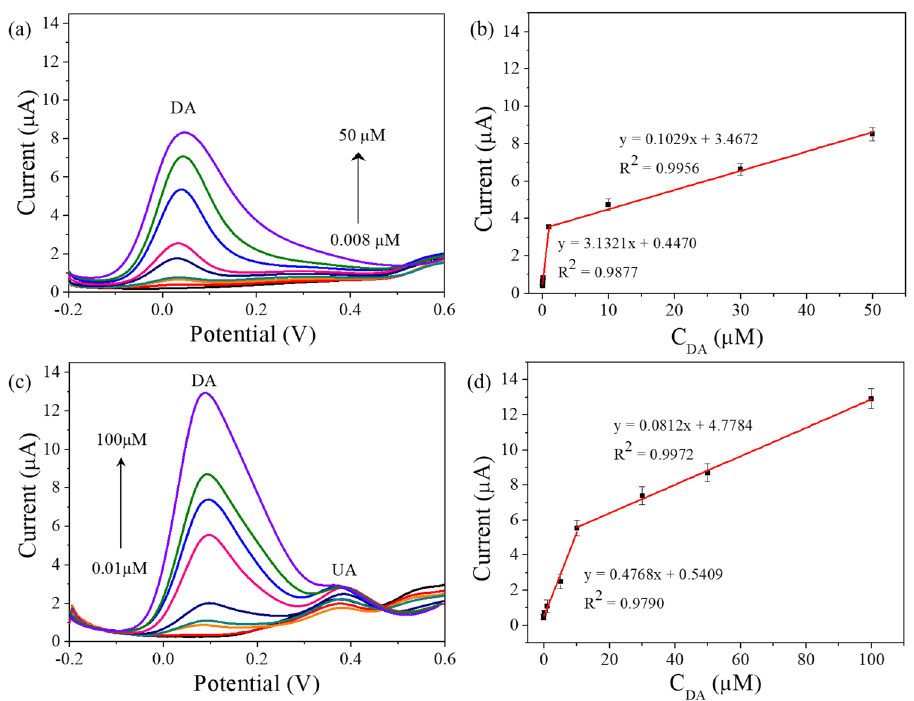
Figure 5. ( a ) DPV curve of the sensor with the GO/PEDOT:PSS composite to various DA concentrations (0, 0.008, 0.01, 0.1, 0.5, 1, 5, 10, 30, and 50 μM) in 0.1 M PBS (pH 7.4); ( b ) A linear fitting for the DPV oxidation peak currents to the various DA concentrations (n = 3); ( c ) DPV curve of the sensor with GO/PEDOT:PSS composite to the different DA concentrations (0, 0.01, 0.1, 1, 5, 10, 30, 50, and 100 μM) in 0.1 M PBS (pH 7.4) that contained 1 mM AA and 50 μM UA; ( d ) A linear fitting of the DPV oxidation peak currents to the various DA concentrations (n = 3).